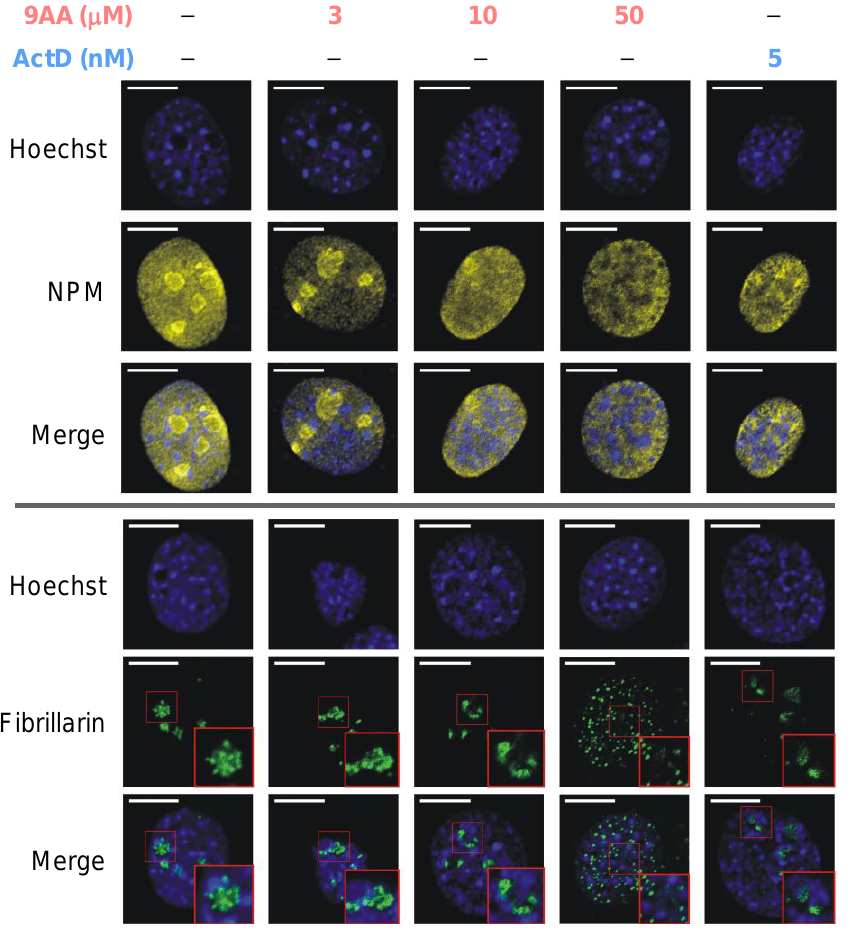
Figure 2. Treatment of 3T3 cells with 9AA induces nucleolar disruption. Cells were treated with the indicated concentrations of 9AA or ActD for 2 h. Nuclei were stained with Hoechst 33342; NPM and fibrillarin were detected by immunofluorescence staining. Representative confocal microscopy images are shown; insets show higher magnification of the indicated areas of the nucleus. Scale bar, 10 μm.